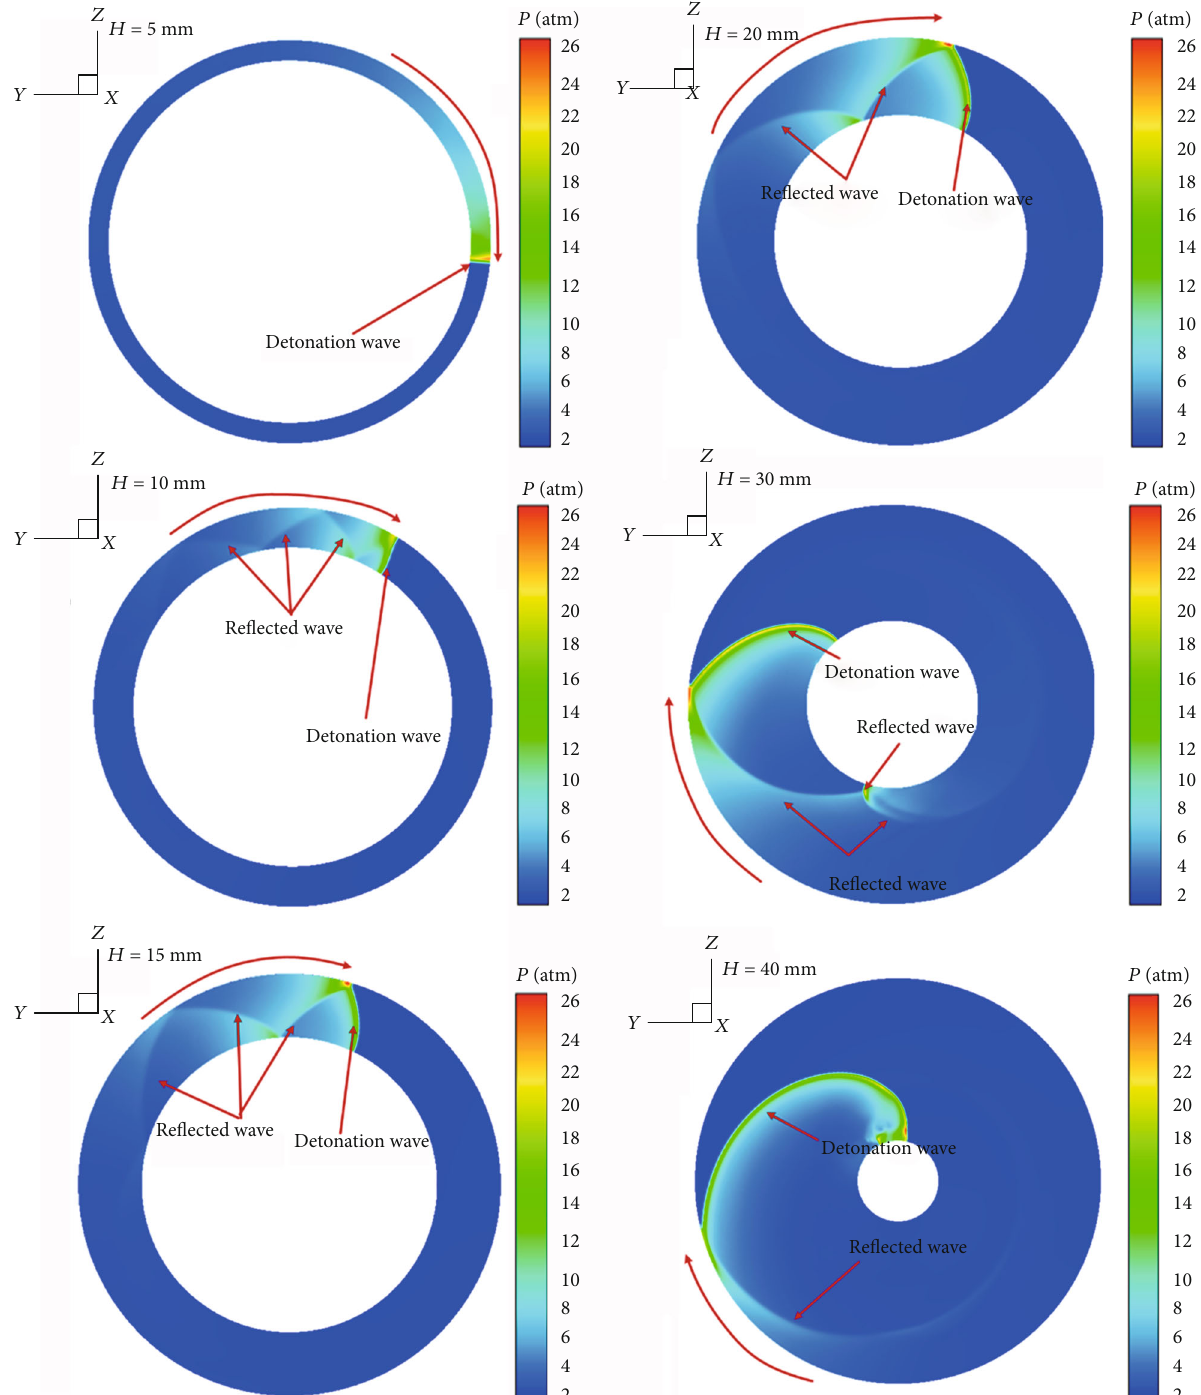
Figure 11: Pressure contours at the entrance with di ff erent chamber